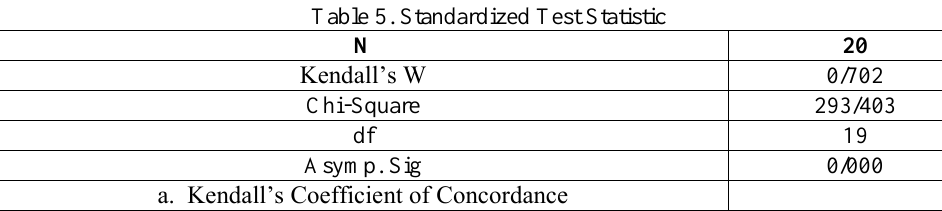
Table 5. Standardized Test Statistic